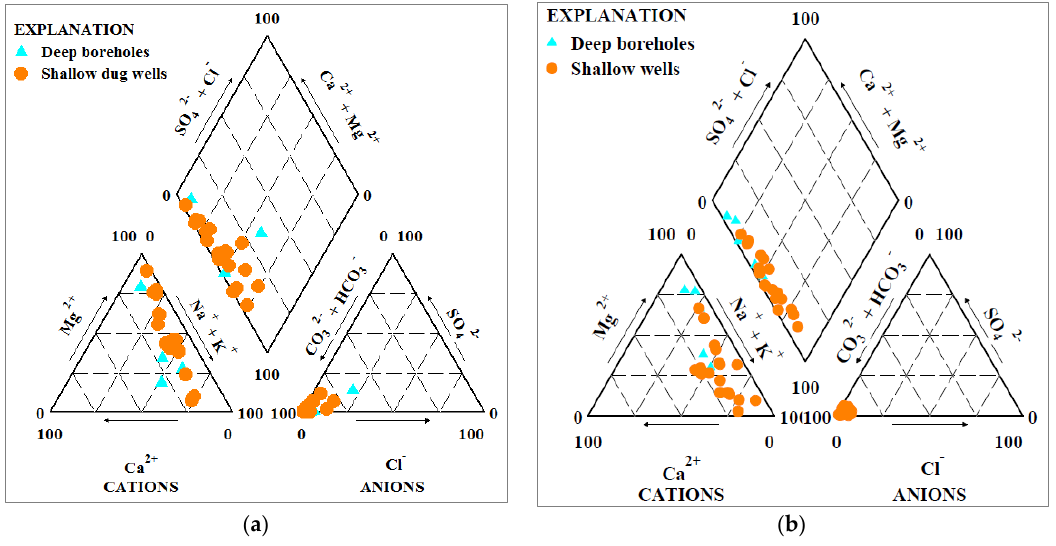
Figure 5. Piper diagram for the chemical composition of groundwater for ( a ) wet season ( b ) dry season. Table 2. One-way ANOVA single-factor results comparing major ions in the wet and dry season. Parameter